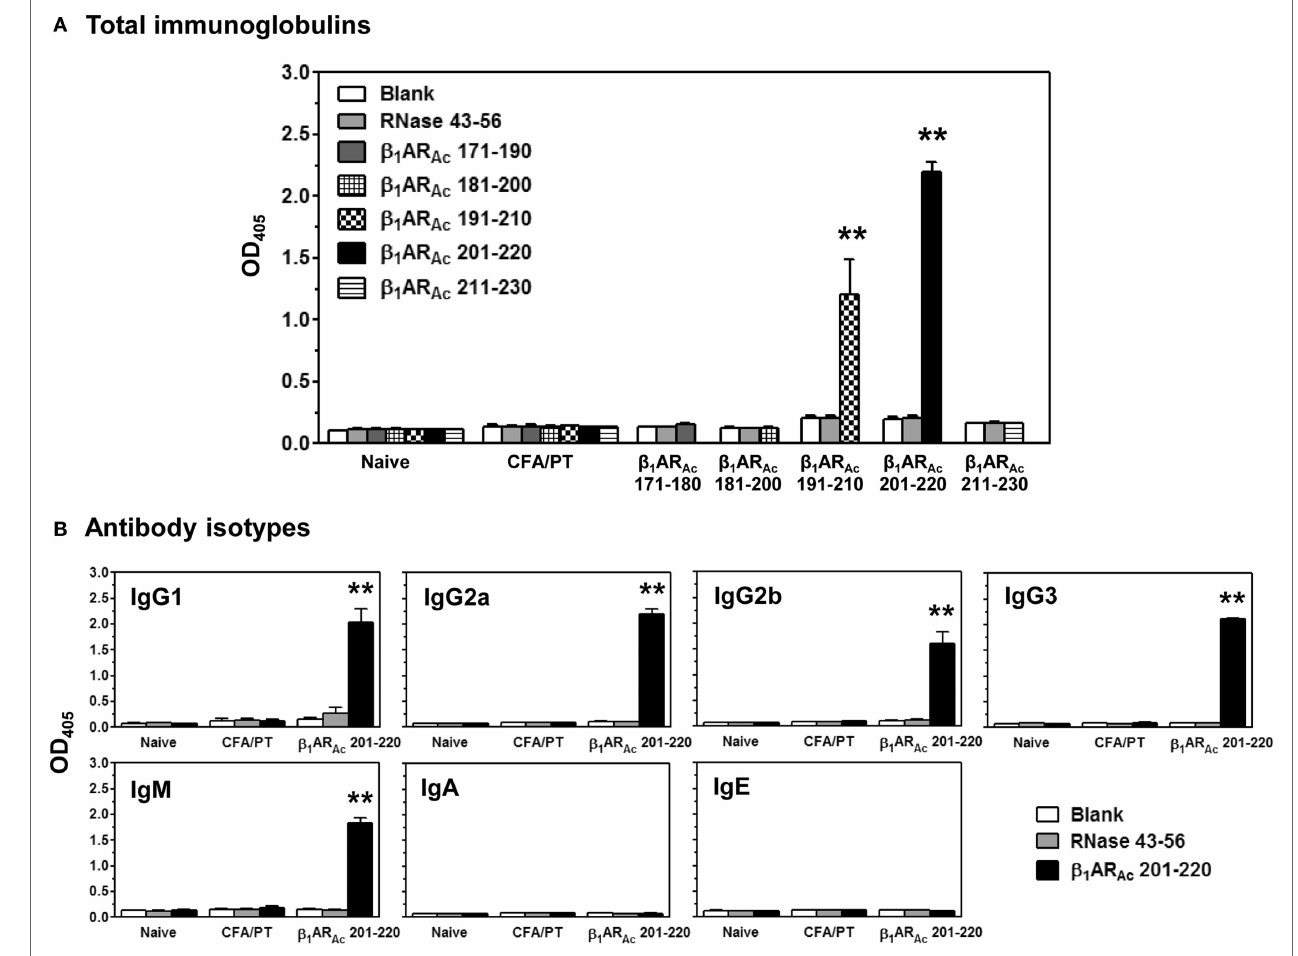
FigUre 7 | Antibody responses induced by β 1 AR Ac peptides. Groups of mice were immunized with β 1 AR Ac 171–190, β 1 AR Ac 181–200, β 1 AR Ac 191–210, β 1 AR Ac 201–220, or β 1 AR Ac 211–230 and after 21 days, serum was collected. Samples with dilutions of 1:100 were added to low-binding plates coated previously with or without the above peptides or RNase 43–56 (control). After adding horseradish peroxidase (HRP)-conjugated, goat anti-mouse detection antibodies for Igs and different isotypes, plates were read at 405 nm to measure the OD values. Each bar represents mean ± SEM values derived from five animals per group. ** P < 0.01 vs. controls. (a) Total immunoglobulins and (B) antibody